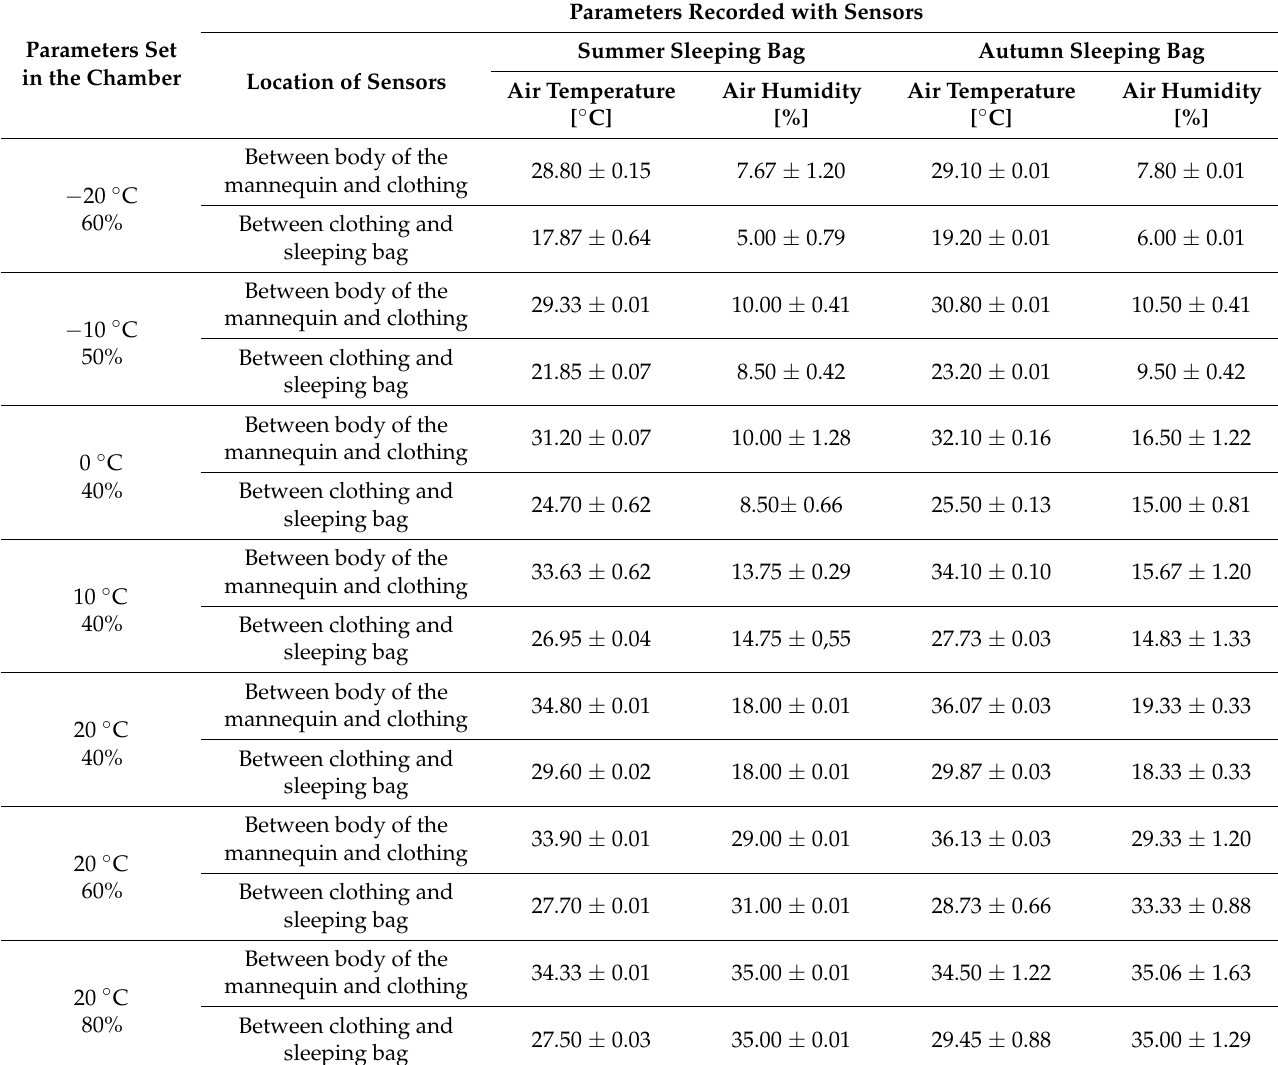
Table 7. Average temperature and humidity measured under the clothing layers of summer and autumn sleeping bags under different weather conditions.